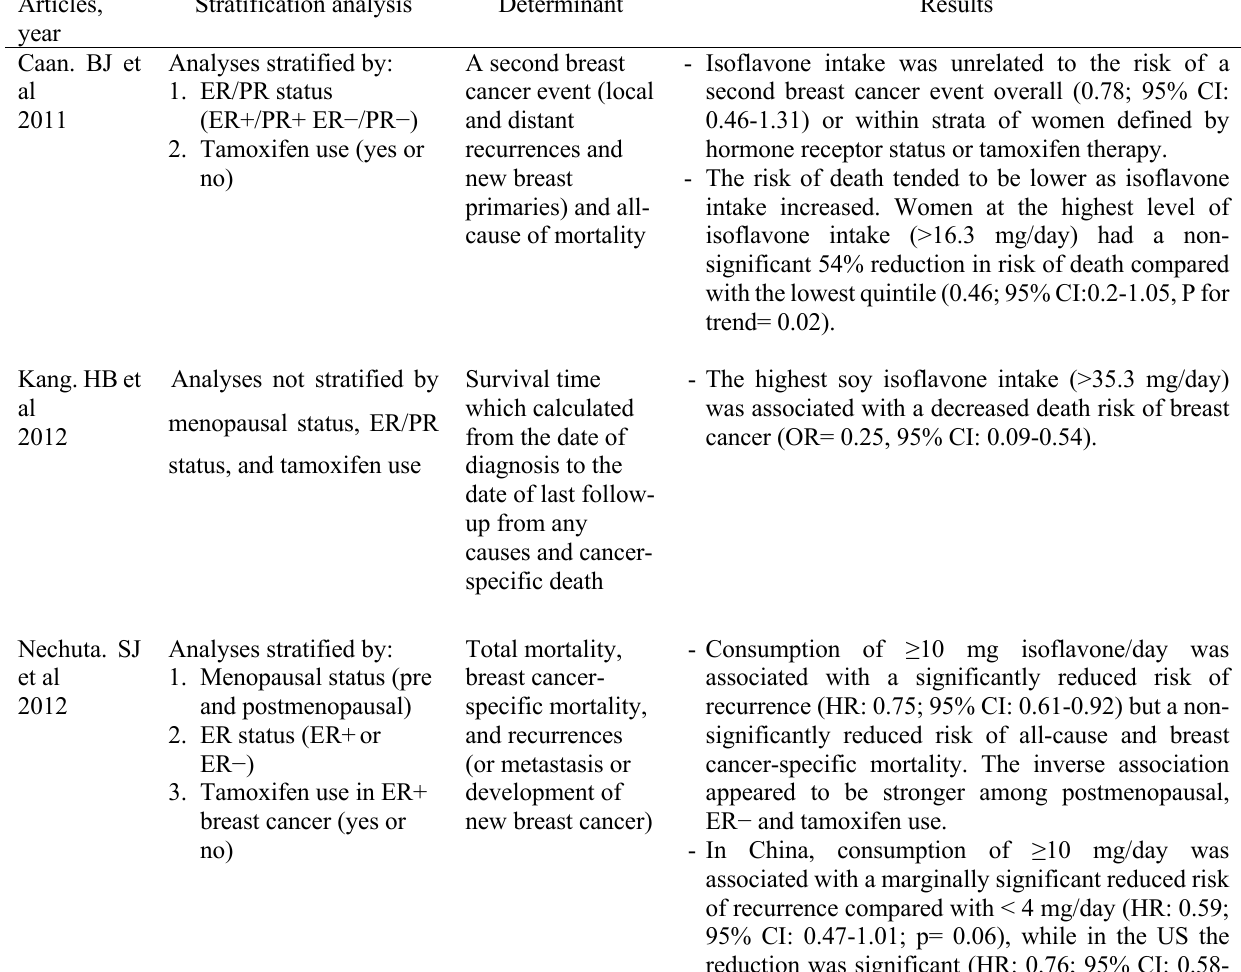
Table 2. Design and results of the selected articles